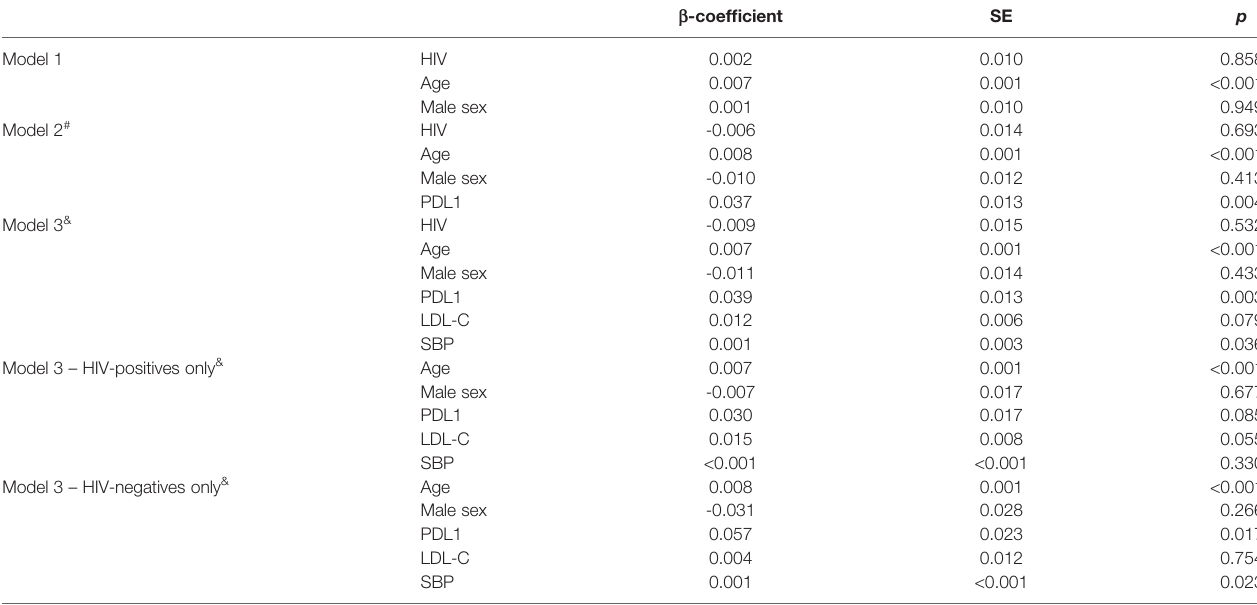
TABLE 3 | HIV, immune activation and carotid intima-media